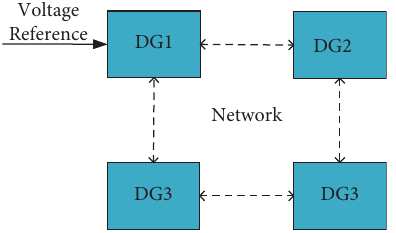
Figure 4: Communication topology of four DGs. Table 1: Simulation parameters of the DC microgrid.